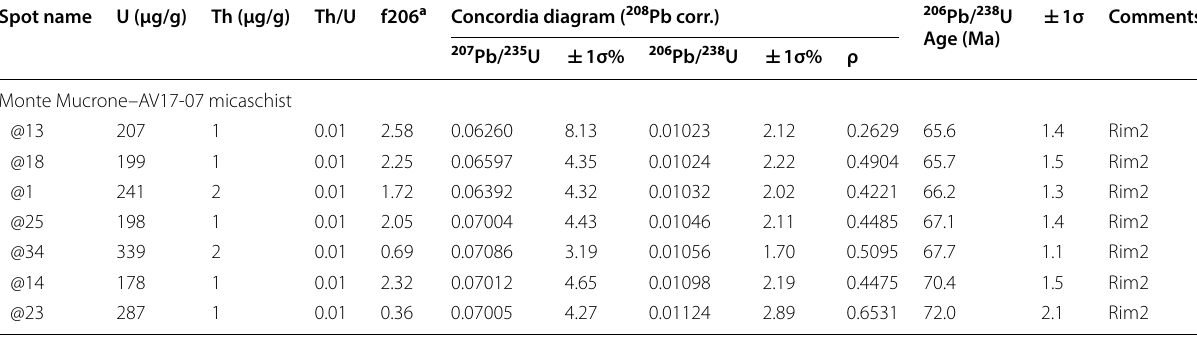
Table 7 U, Th and Pb SIMS zircon data of the micaschist AV17-07 from Monte Mucrone that yield the age of the Alpine HP metamorphic